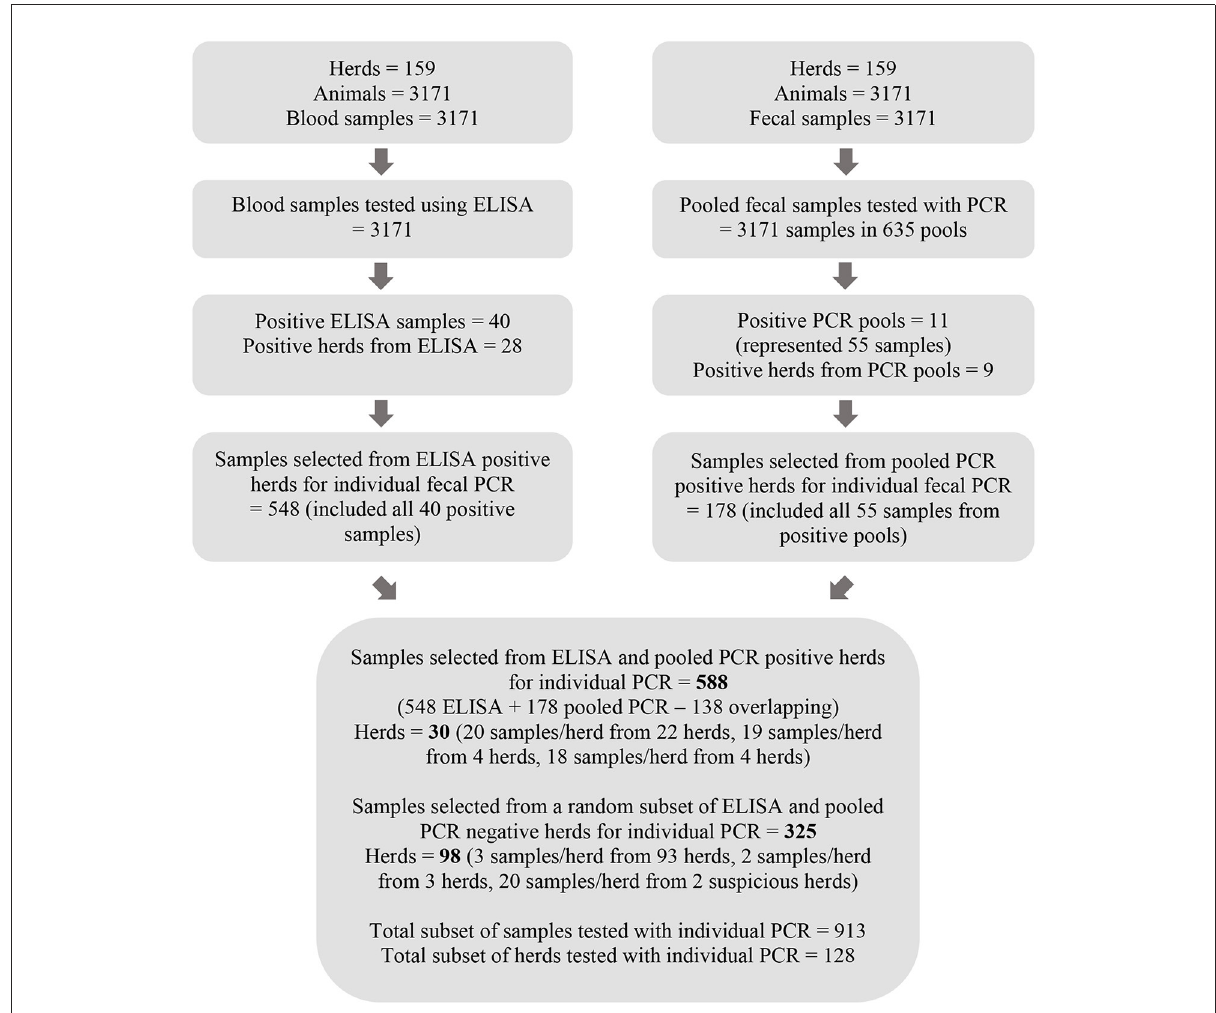
FIGURE1 Flow chart depicting the process for testing serum samples with MAP ELISA and pools of five fecal samples with PCR as well as the method by which a subset of fecal samples was selected for further testing with individual